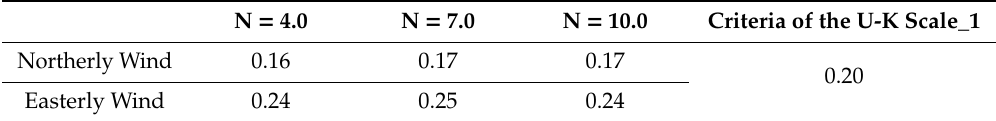
Table 6. Comparison of the values of the U-K Scale_1 at wind turbine hub height (z* = 60 m) under different N values.